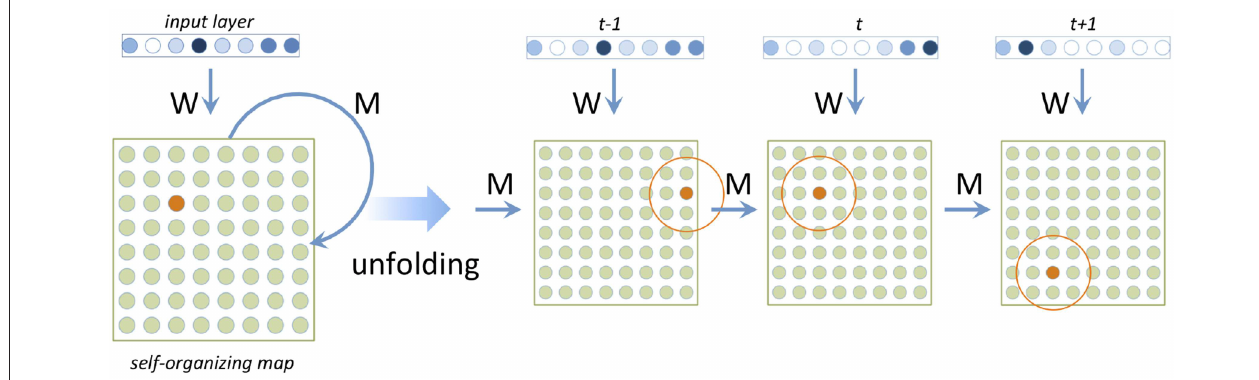
FIGURE 1 | Architecture and unfolded view of a TSOM . Orange nodes represent Best Matching Units activated at successive time ticks.